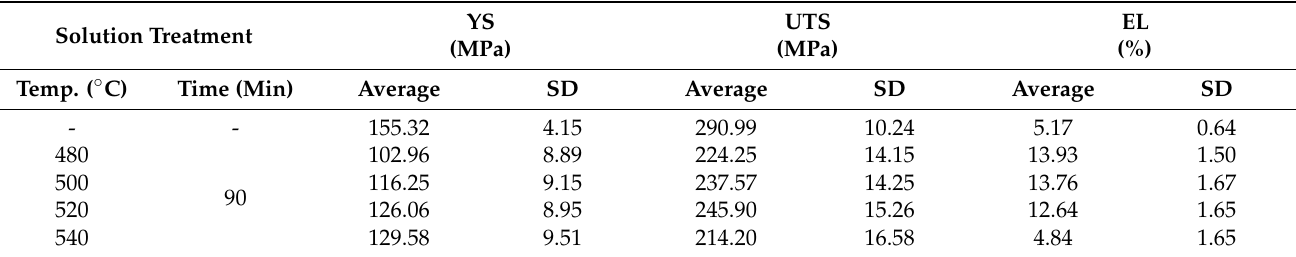
Figure 8. Stress–strain curves of the as-cast and solution-treated alloys. Table 5. Tensile properties of as-cast and solution-treated